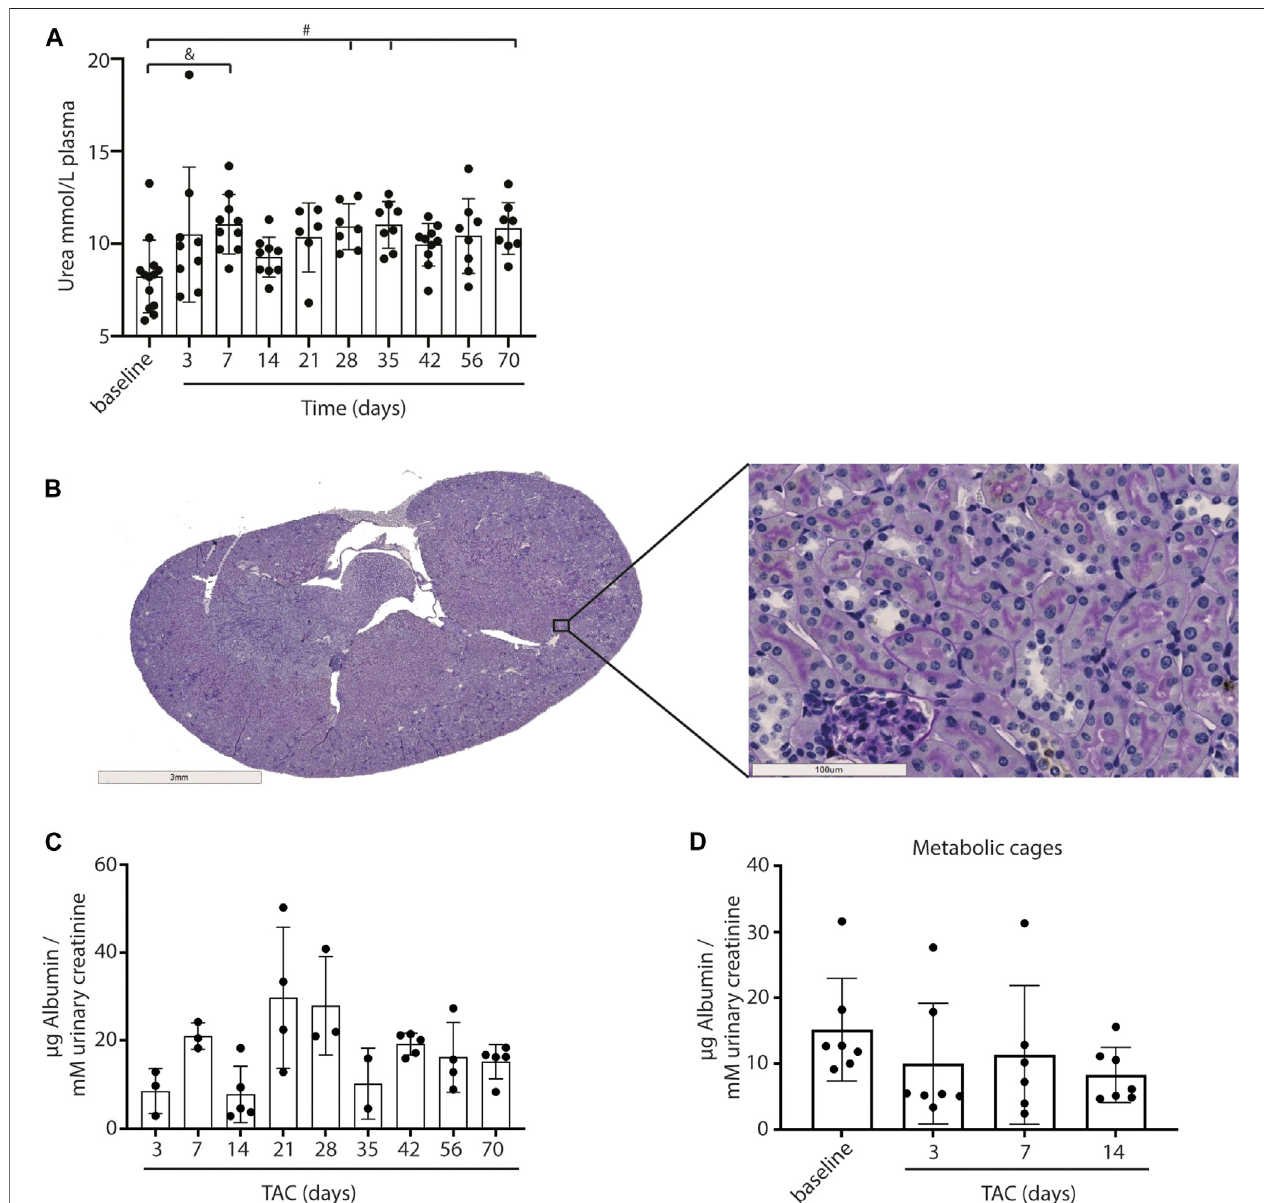
FIGURE 4 | Kidney morphology, signs of damage and albumin levels. Urea levels in plasma were signi fi cantly upregulated over time after TAC versus baseline (A) . No structural abnormalities were observed in glomeruli and tubuli (PAS staining) (B) . No increase in urinary albumin (µg corrected for mM urinary creatinine) levels could be observed after TAC (C) . Urine albumin levels (µg corrected for mM urinary creatinine) post-TAC were not different from baseline (metabolic cages) (D) . Mean ± SD. # p < 0.05; & p < 0.01.